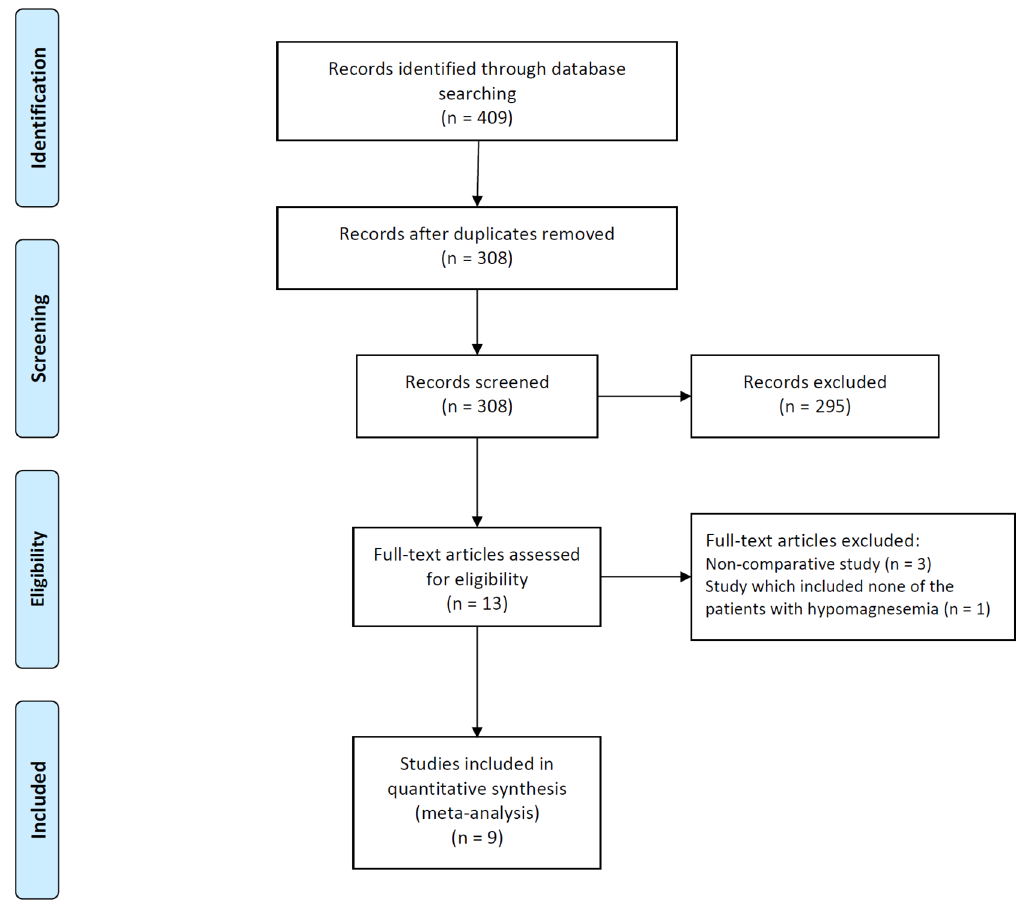
Figure 1. Flow diagram of studies included in the meta-analysis. PPI, proton pump inhibitor.